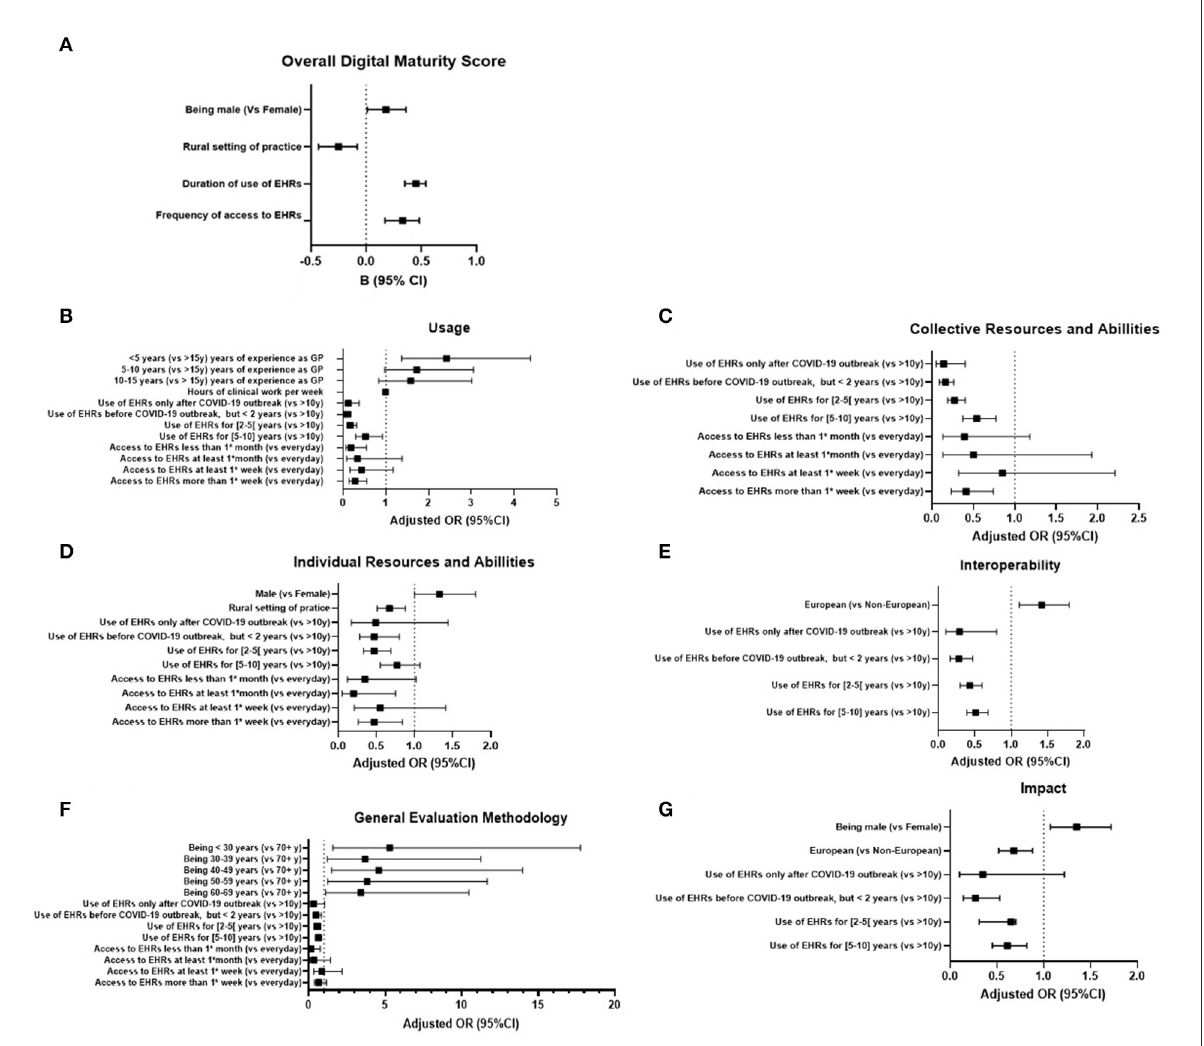
FIGURE2 Forest plots of multivariable analysis for characteristics associated with overall digital maturity (A) and its dimensions-usage (B) , collective resources and abilities (C) , individual resources and abilities (D) , interoperability (E) , general evaluation methodology (F) and impact (G) . B , beta; OR, odds ratio; CI, confidence interval; vs, in comparison